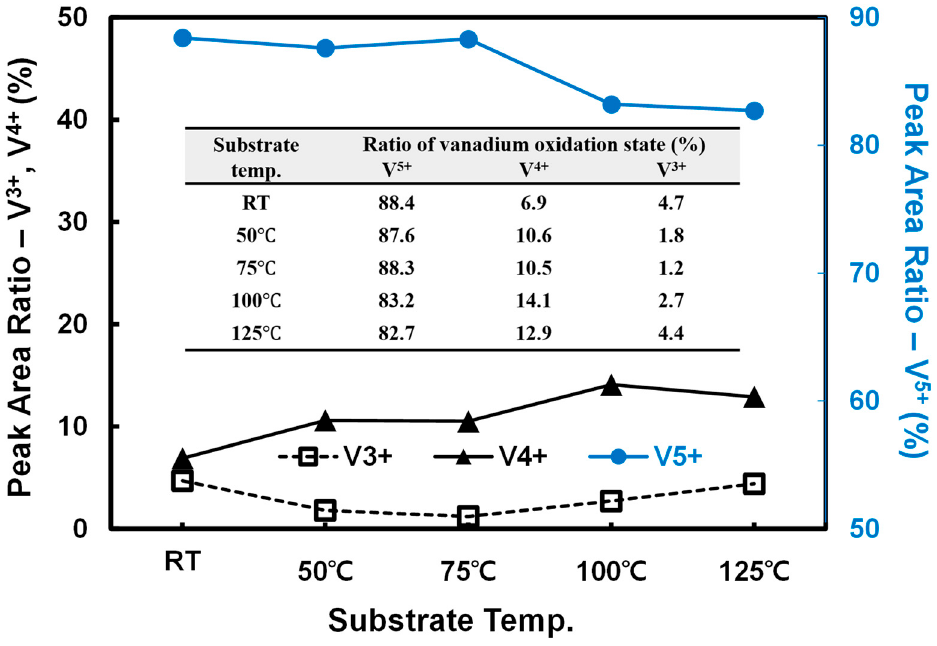
Figure 9. Integrated peak area ratios of vanadium oxidation states based on the measured V 2p XPS profiles.